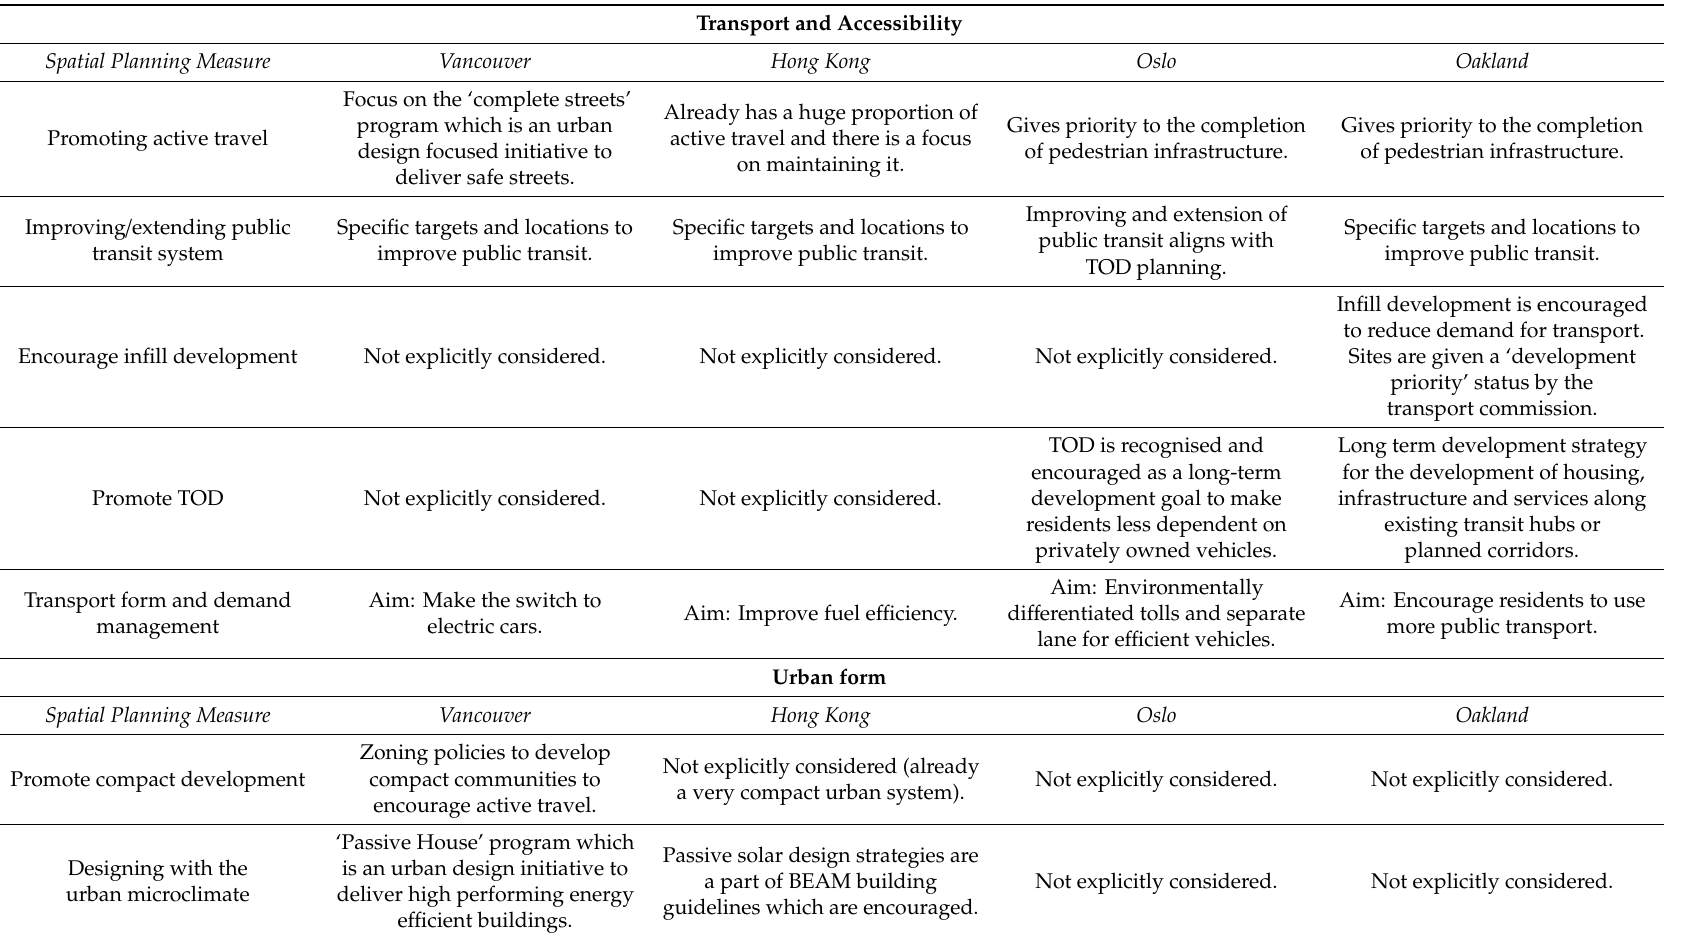
Table 3. Comparative analysis of coverage of components of spatial